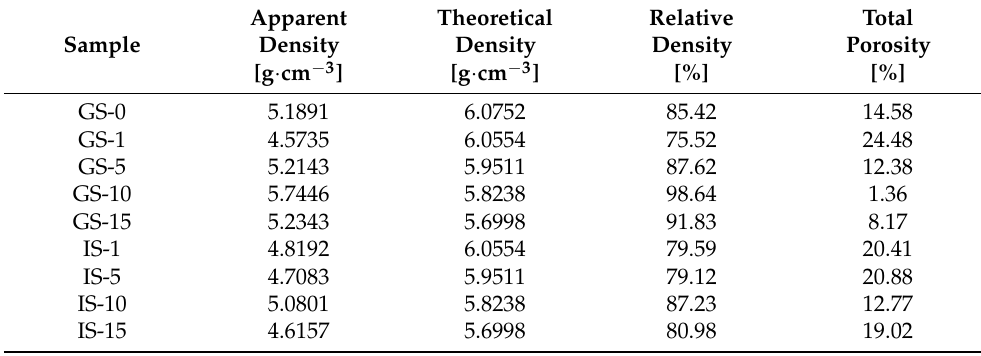
Table 5. The apparent, theoretical and relative densities as well as the corresponding total porosity values for the studied samples obtained after 2 h of sintering in air at 1773